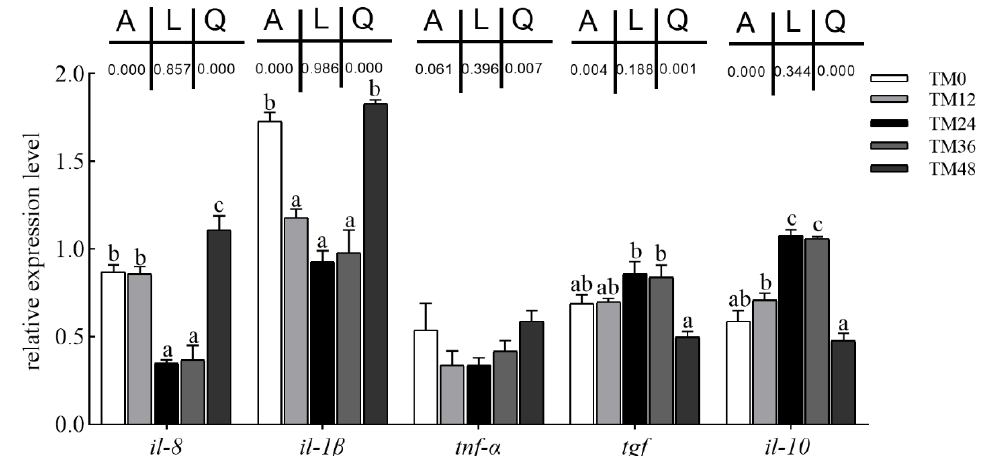
9 of 14 Figure 3. Effects of different levels of TM, instead of FM, on the expression of antioxidant genes in the liver of Micropterus salmoides. Values with different letters represent significant differences in Tukey’s test ( p < 0.05). A = the variance analyzed by one-way ANOVA; L = linear trend analyzed by orthogonal polynomial contrasts; Q = quadratic trend analyzed by orthogonal polynomial contrasts. In Figure 4, there were significant quadratic relationships between the expression